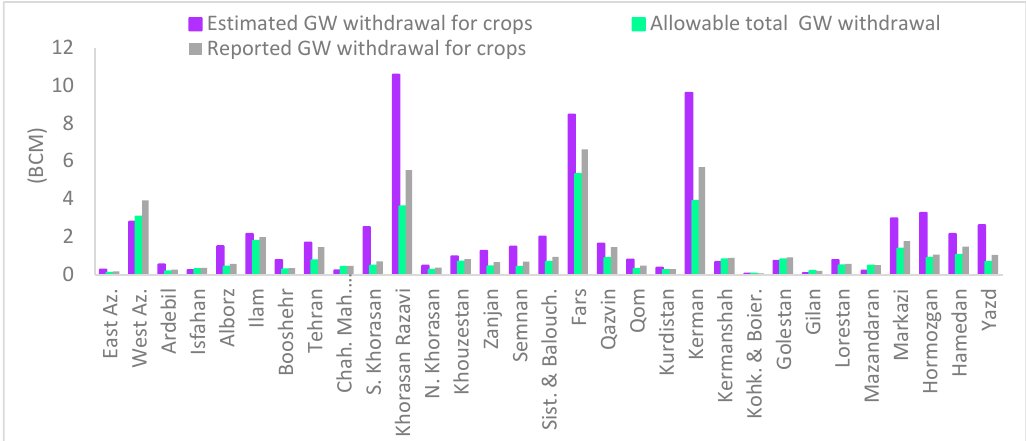
Figure 12. Comparison of estimated, reported, and allowable agricultural water withdrawal at the provincial level.